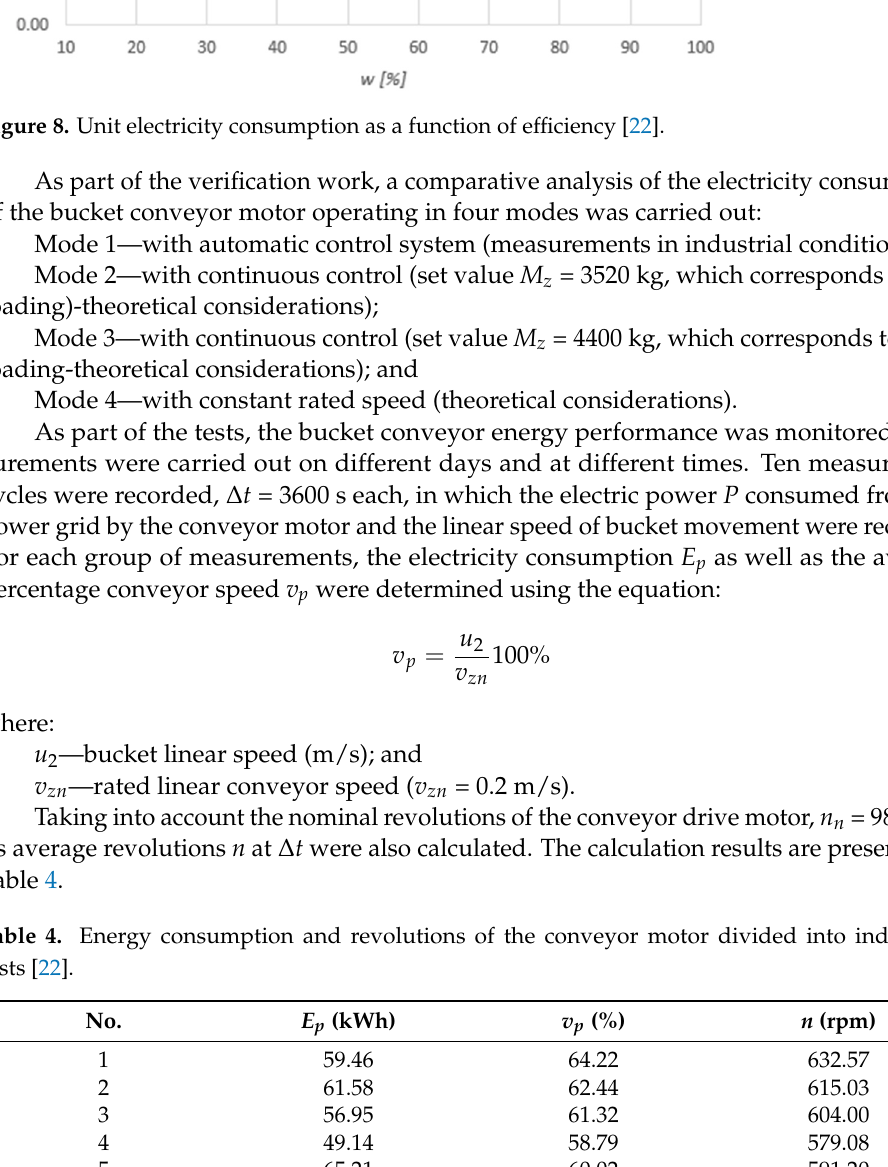
Table 5 summarizes the basic operating parameters of the bucket conveyor in the four motor speed modes under